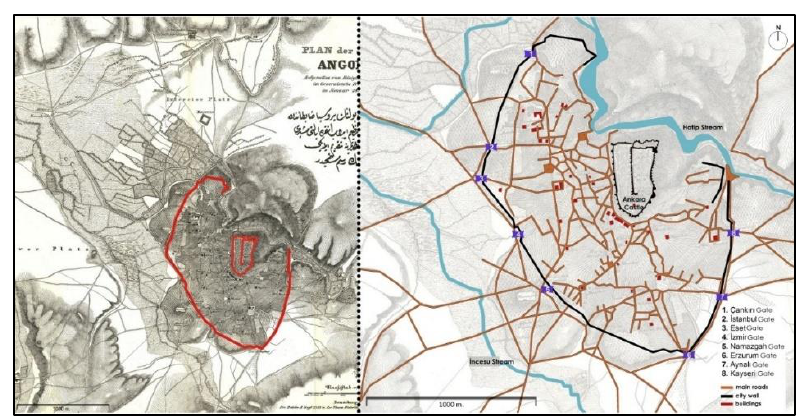
Figure 6 The 1839 map & its spatial analysis.